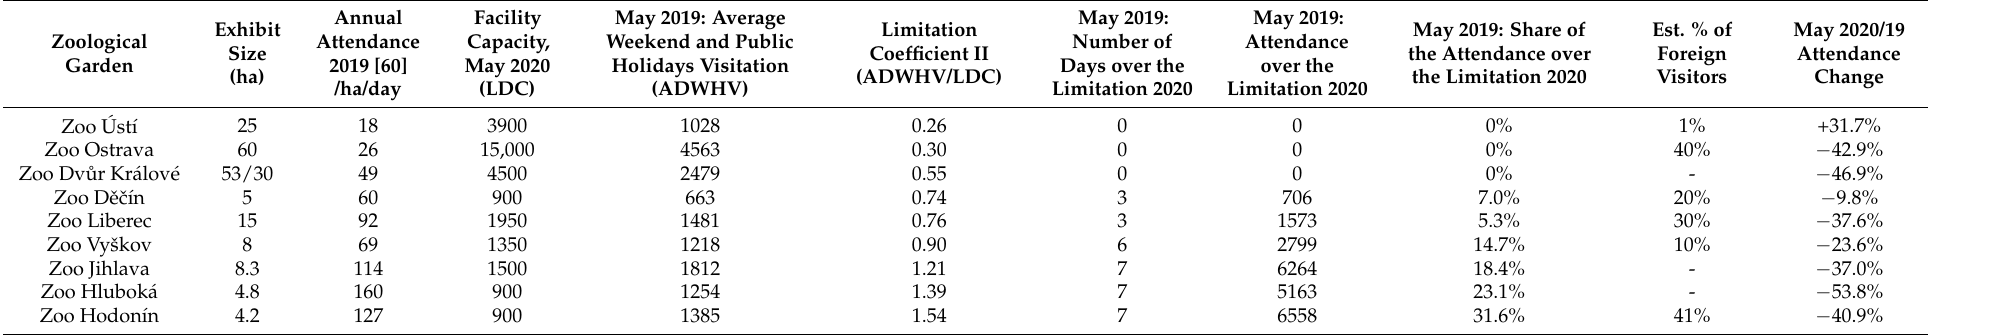
Table 3. The Comparison of the Attendance Parameters of Selected Czech Zoos ( N = 9; sorted by Limitation coefficient II). Zoological